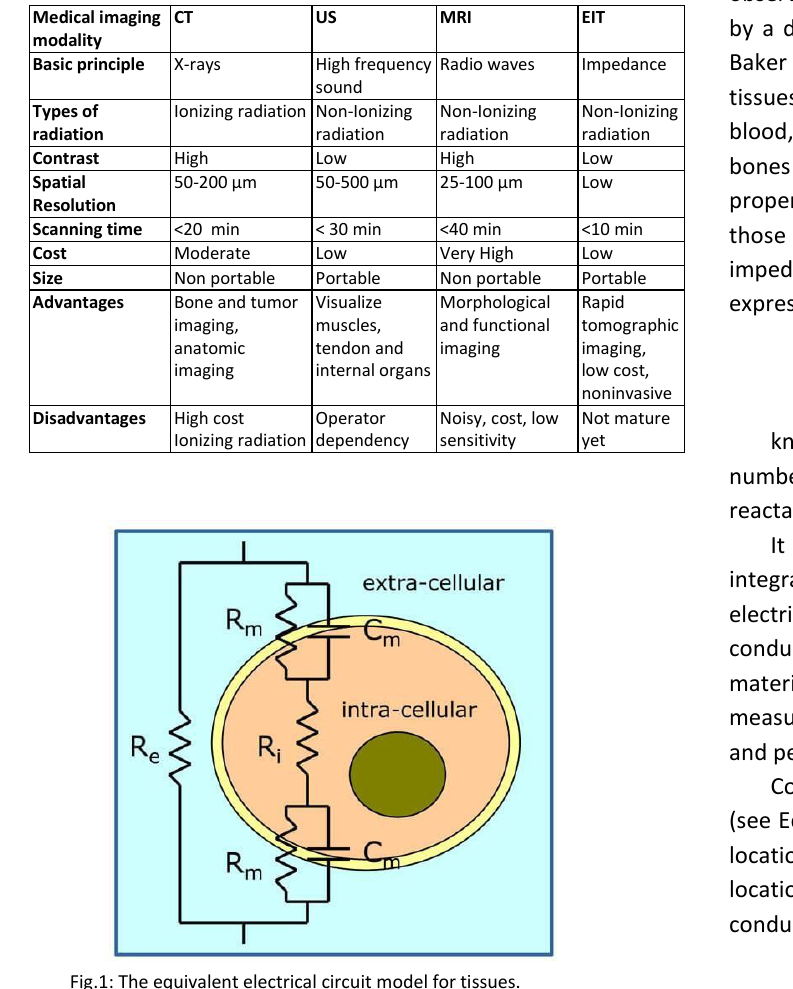
Table 1: Comparison between different imaging modalities.